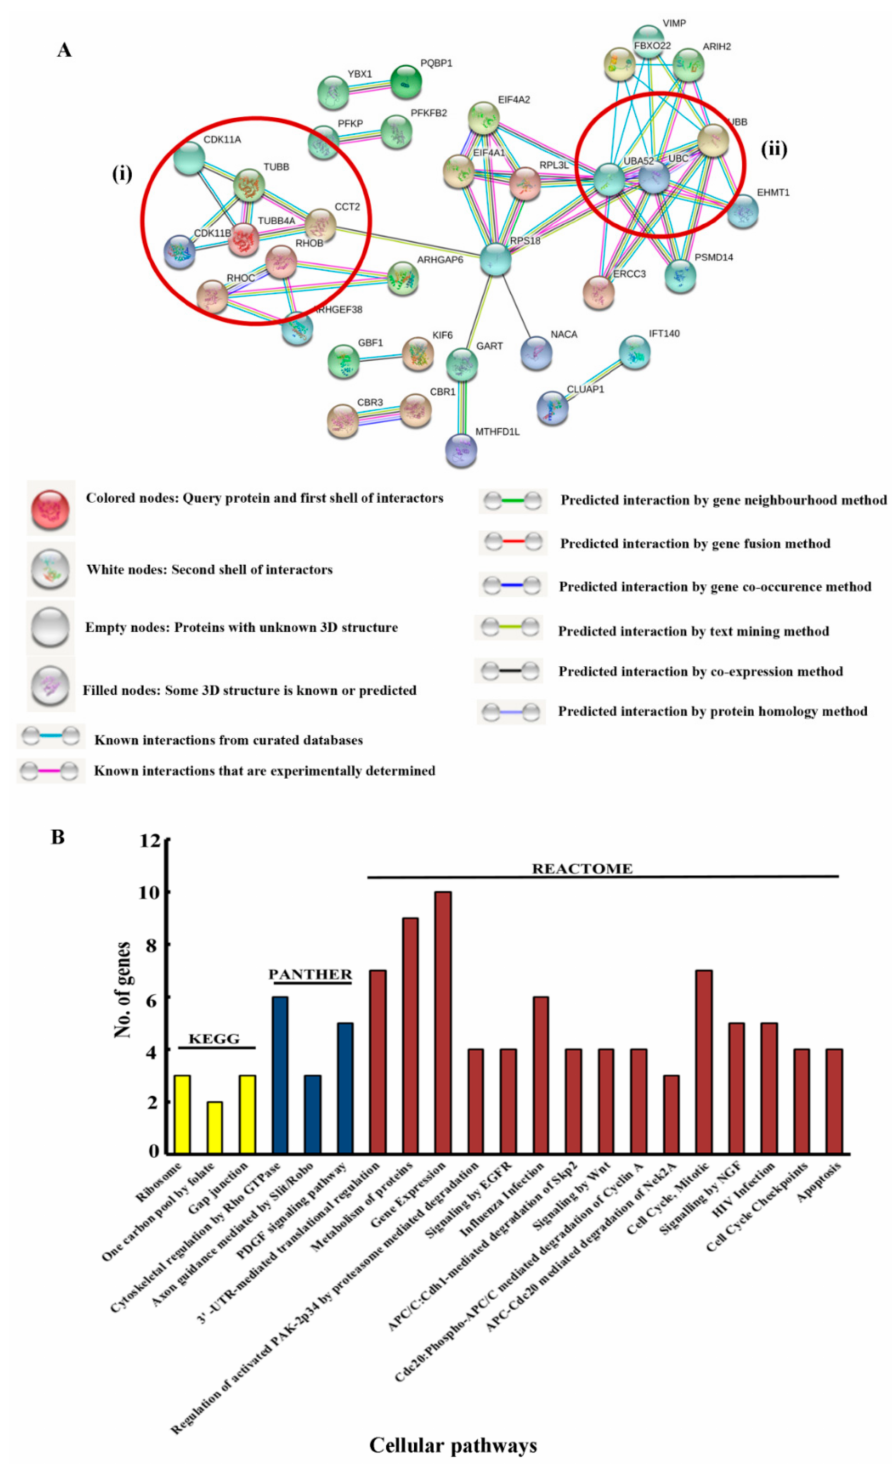
Figure 2. ( A ) The interactome of the upregulated proteins obtained from STRING v 11.0. The clusters corresponding to the ( i ) cytoskeletal regulatory proteins and cell cycle proteins and ( ii ) apoptotic proteins have been demarcated. Color coding of the nodes and networks is stated below the STRING output. ( B ) Gene Ontologies enriched by the upregulated proteins (pathways enriched as analyzed by